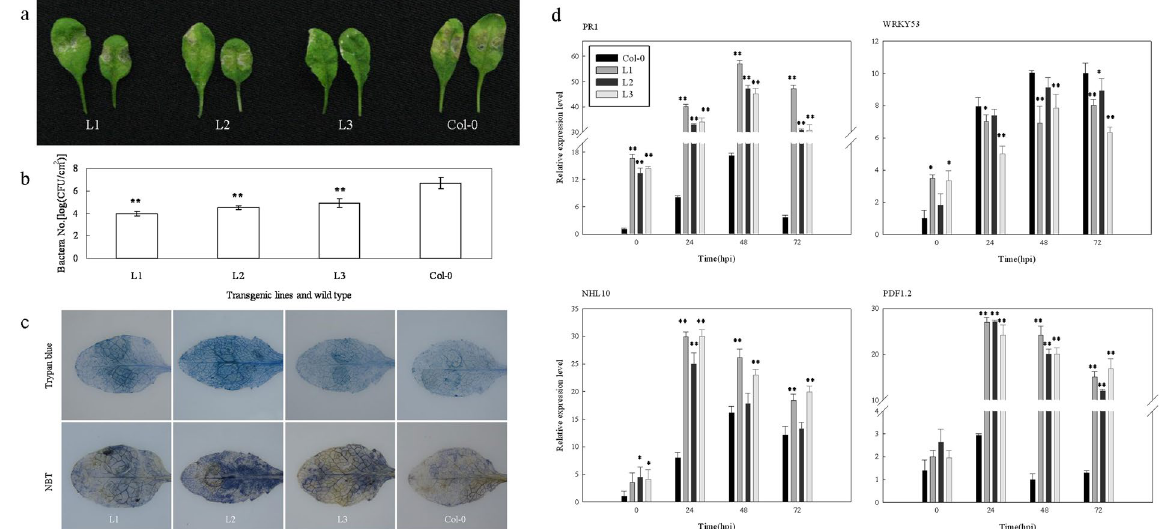
Figure 6. Response of VqTLP29 over-expressing Arabidopsis thaliana lines to Pst DC3000 inoculation. ( a ) Disease symptoms in representative rosettes of the 4-week old VqTLP29 transgenic line L1, L2, L3 and Col-0 after DC3000 inoculation for 3 days. Leaves were injected with the DC3000 suspension using 1 mL needless syringes and kept highly moisturizing until the lesion shown. ( b ) The number of bacteria of the VqTLP29 transgenic lines and Col-0 3 days post DC3000 inoculation. The colony counting assay of the transgenic lines and Col-0 was carried out in three independent experiments. Asterisks indicate statistical significance ( ** P < 0.01, one-way ANOVA). ( c ) Cell death and O 2 − accumulation in the VqTLP29 transgenic lines and Col-0 72 h post DC3000 inoculation. Three infected leaves of the transgenic lines and Col-0 were required for each stain in three independent experiments. ( d ) Expression levels of disease resistance genes in the VqTLP29 transgenic lines and Col-0 at 0, 24, 48 and 72 hpi following DC3000 inoculation. Asterisks indicate statistical significance ( * 0.01 < P < 0.05, ** P < 0.01, one-way ANOVA). The experiments were repeated three times with consistent